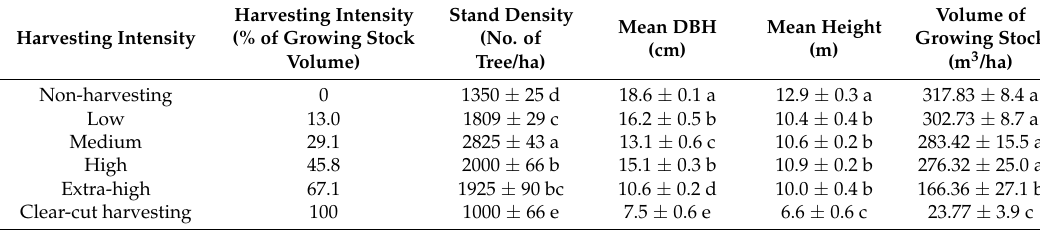
Table 2. General situation of stand in studied area 15 years after different harvesting intensities.